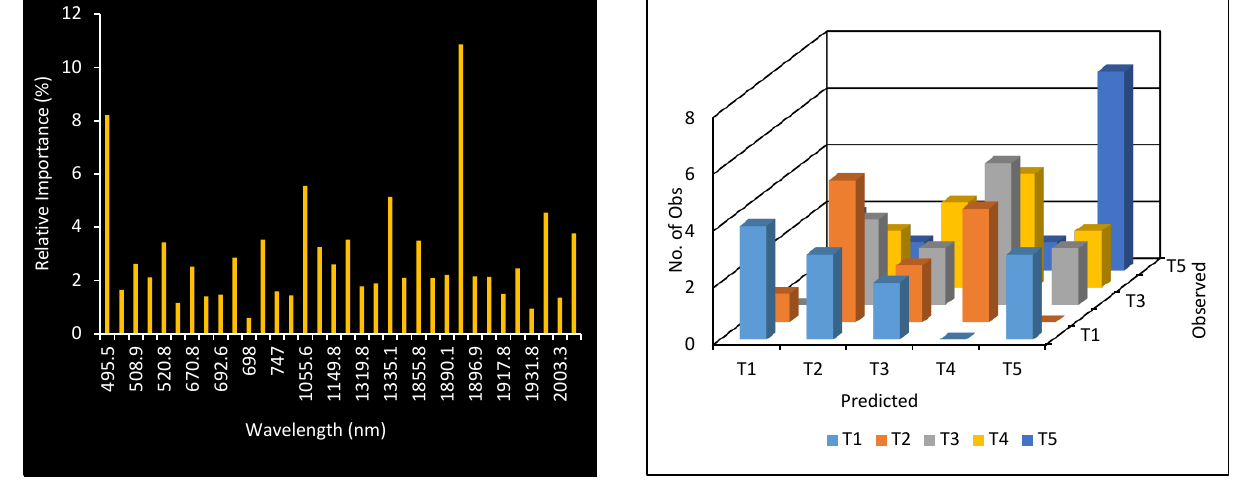
Figure 7. Important Variables Identified by GBM Model using Figure 9. Classification Matrix for RF Model using Full Spectra Full Spectra The RF model identified different important variables from those identified by the GBM model. No bands in the blue and green regions of the spectrum were identified as important, as shown in figure 10. The important variables are instead distributed across the red, near-infrared, infrared regions of the spectrum. The variable with the highest influence (100%) lies in the mid- infrared region (1959.5 nm).